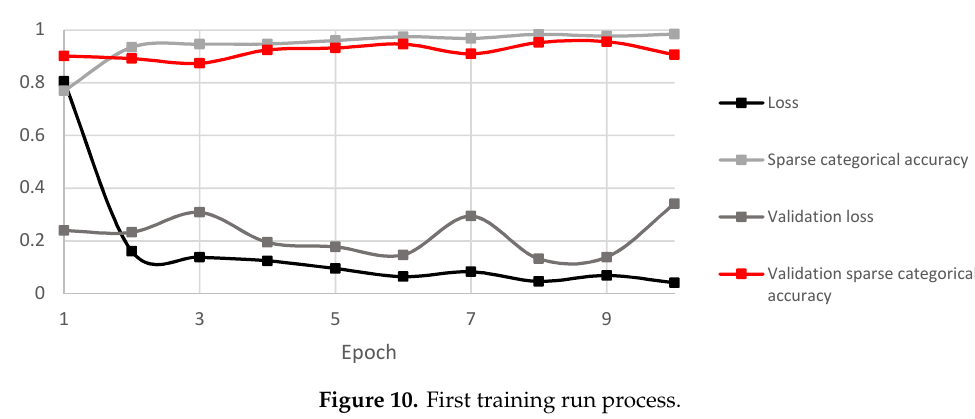
Figure 10. First training run process.